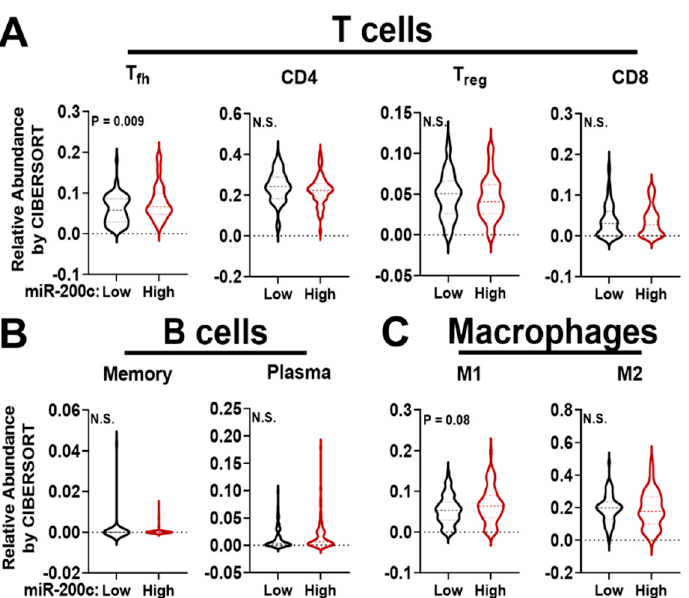
Figure 1. Relative immune cell abundance as predicted by gene expression using CIBERSORT on breast cancer specimens with high versus low miR ‐ 200c. mRNA profiling curated by The Cancer Genome Atlas (TCGA), Nature 2012 dataset [31] was assessed for the relative amounts of ( A ) T cells, ( B ) B cells, and ( C ) macrophages using CIBERSORT [32]. Specimens were stratified by expression of miR ‐ 200c in the lowest quartile (Low, N = 65) or highest quartile (High, N = 64). Shown is the median number of predicted immune cells. Student’s unpaired two ‐ tailed t ‐ test.